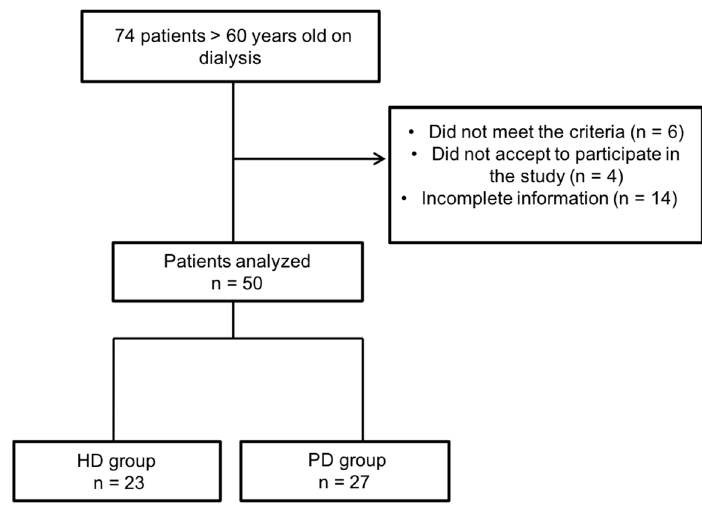
Figure 1. Flowchart of the study selection process. HD, hemodialysis; PD, peritoneal dialysis.